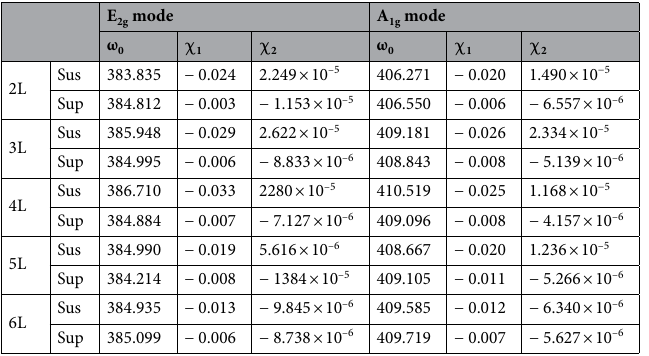
Table 1. Temperature coefficients of the suspended and supported few-layer MoS 2 samples with polynomial fitting to the second